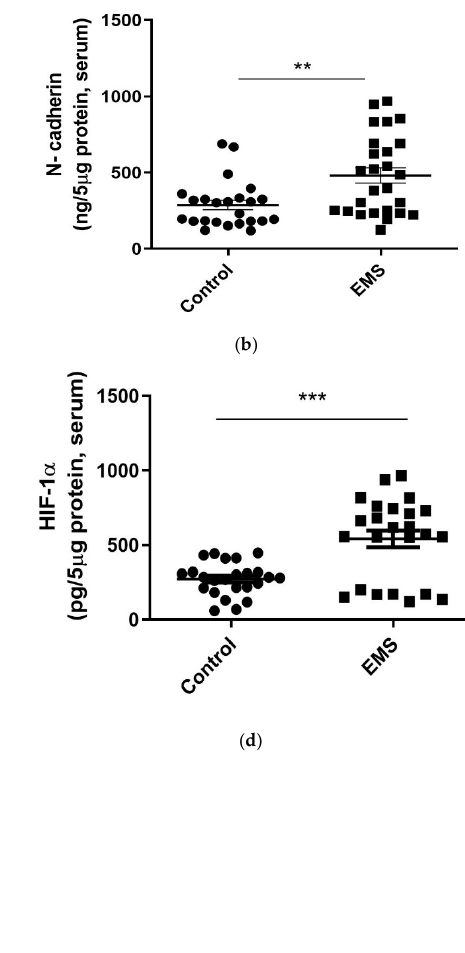
( d ) Figure 2. Protein levels of proinflammatory IL-6 ( a ), IL-8 ( b ), IL-12 ( c ), and anti-inflammatory IL-10 ( d ) in follicular fluid (FF) samples from control women and EMS patients. The data are reported as the mean values ± SD of three independent experiments each performed in duplicate. Statistical analysis was performed by unpaired t -test: *** p < 0.001 versus control. 3.4. Evaluation of EMT Markers in Serum and Follicular Fluid of Control and Patients with Endometriosis The putative association of EMT with EMS and its correlation with IVF-related pa- rameters was evaluated by examining the concentrations of EMT-related biological mark-